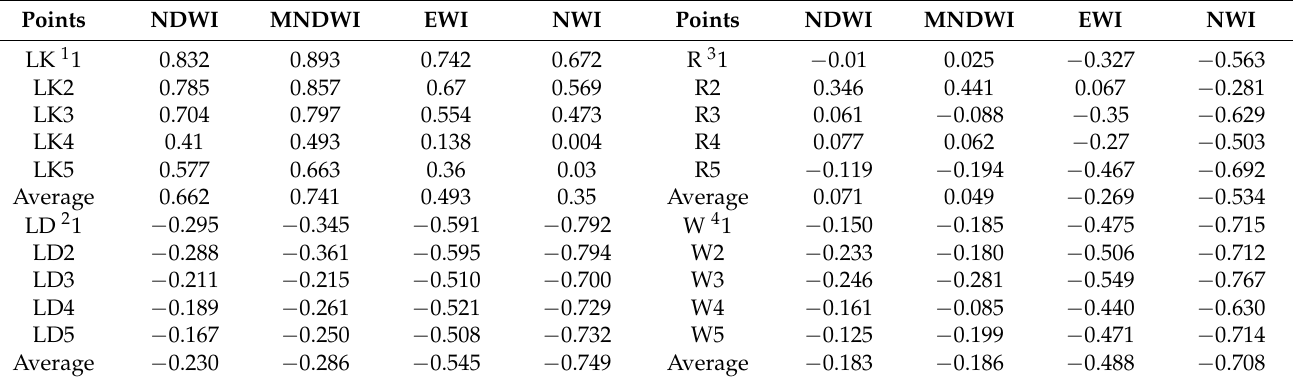
Table 3. Numerical value of different features